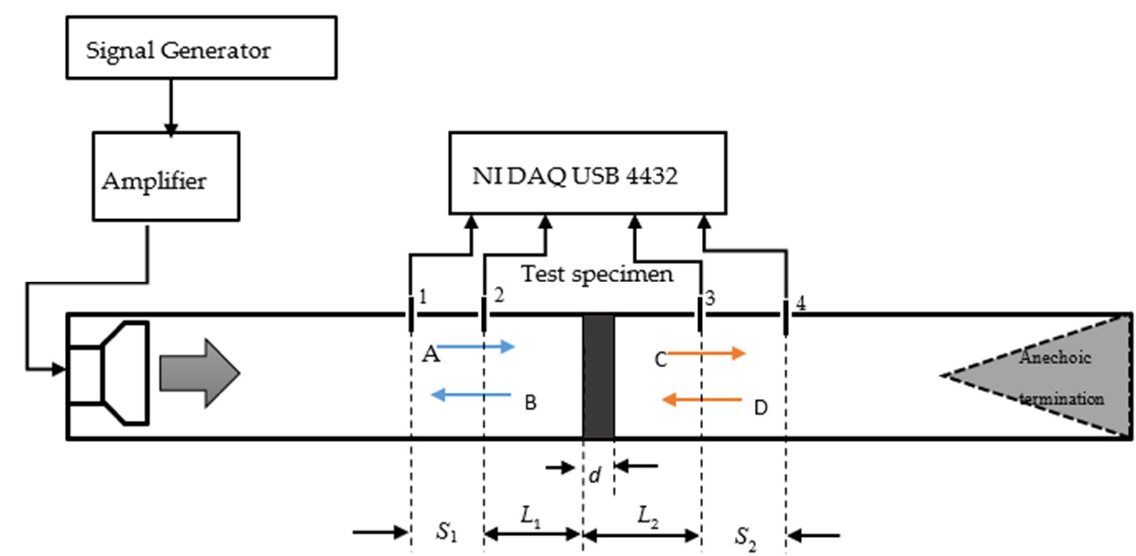
Figure 2. Schematic of the measurement setup.